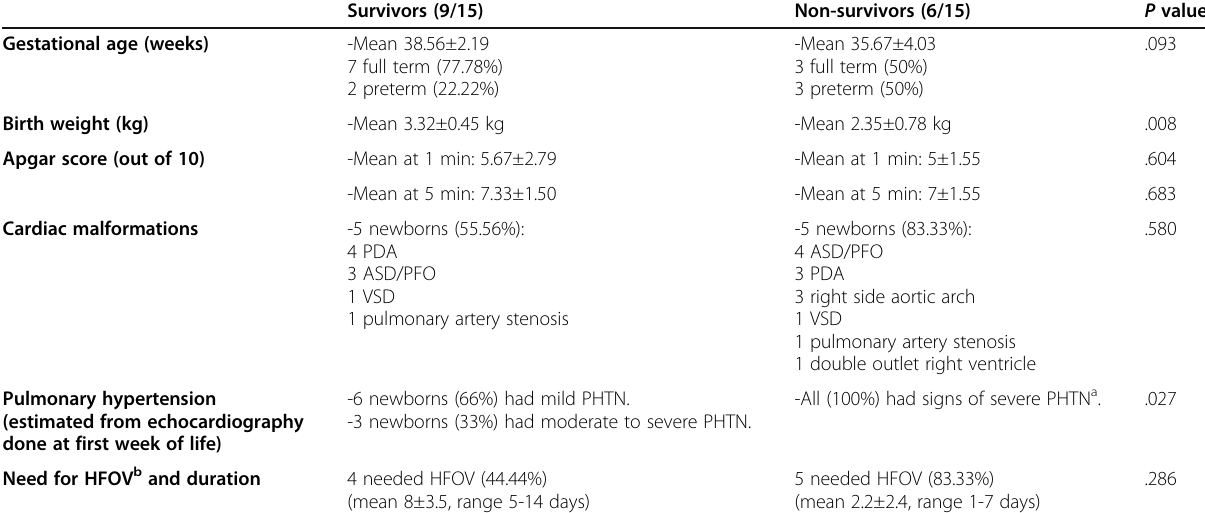
Table 1 Comparison between survivors and non survivors of right-sided congenital diaphragmatic hernia patients Survivors